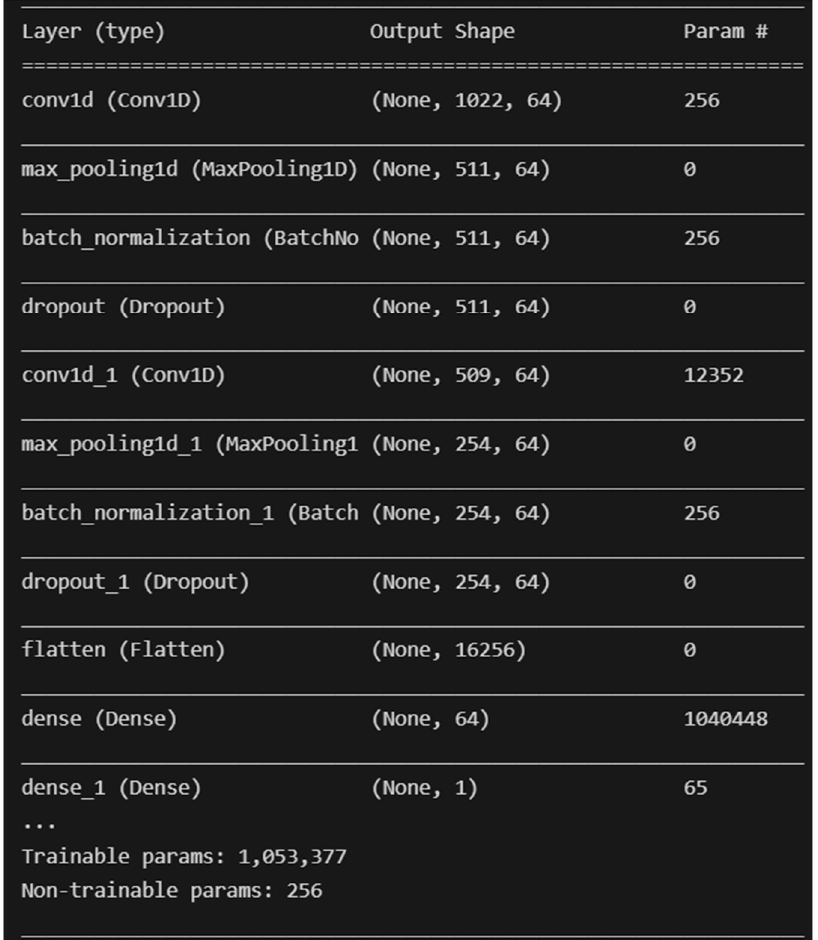
Figure 6. Overall architecture of the developed CNN